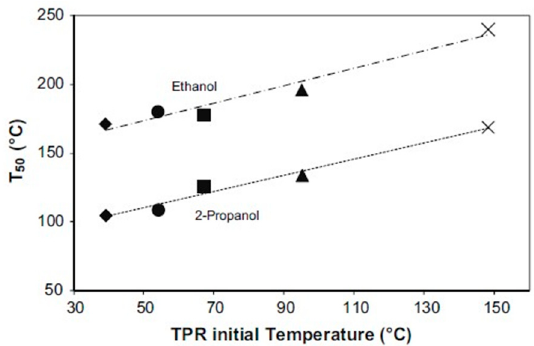
Figure 5. Temperature at which the 50% of conversion of ethanol and 2-propanol was achieved (T 50 ) versus TPR (temperature-programmed reduction) initial temperature: (filled diamond) Au-Ag / CeO 2 ; (filled circle) Au-Cu / CeO 2 ; (filled square) Au / CeO 2 ; (filled triangle) Ag / CeO 2 ; (times) Cu / CeO 2 . Figure from [68], Copyright 2015, Springer Nature.